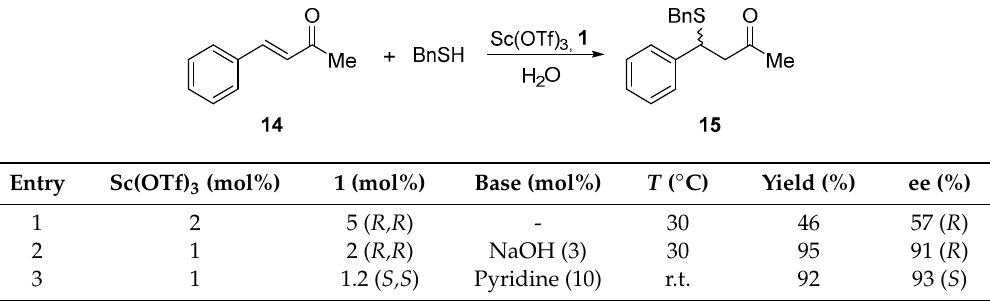
Table 4. Conjugate addition of benzylthiol on α , β -unsaturated ketone 14 .